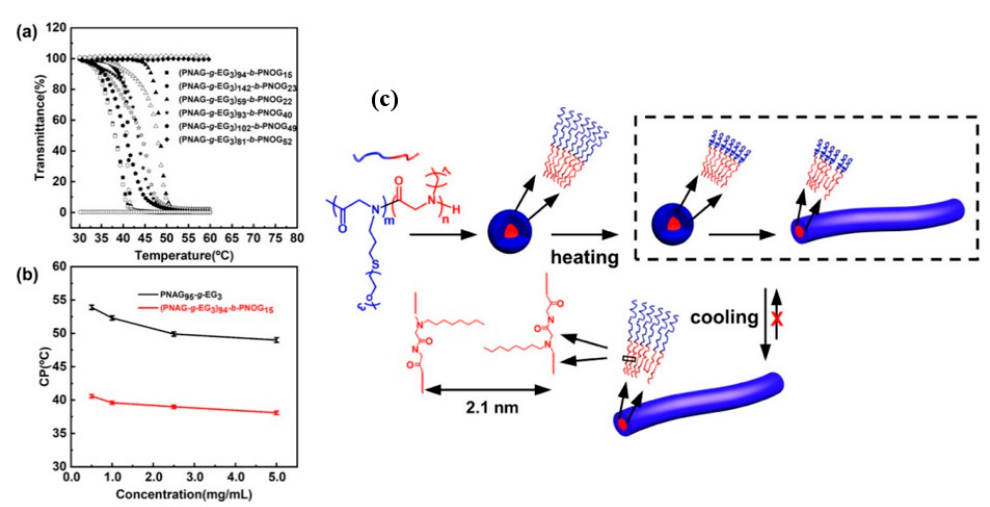
Figure 11. ( a ) Plots of transmittance versus temperature for aqueous solutions of (PNAG- g -EG3)- b -PNOG at a concentration of 5 mg/mL. Filled symbol: heating ramp and open ataconcentrationof5mg / mL.Filledsymbol: heatingrampandopensymbol: coolingramp. ( b )Plotsof T cp symbol: cooling ramp. ( b ) Plots of T cp versus concentration for aqueous solutions of versus concentration for aqueous solutions of (PNAG- g -EG 3 ) 94 - b -PNOG 15 and PNAG 95 - g -EG 3 at different (PNAG- g -EG 3 ) 94 - b -PNOG 15 and PNAG 95 - g -EG 3 at different concentrations. ( c ) Scheme of sphere and concentrations. ( c ) Scheme of sphere and cylinder structure of the crystalline diblock cylinder structure of the crystalline diblock copolypeptoids. Reprinted with permission from [76].